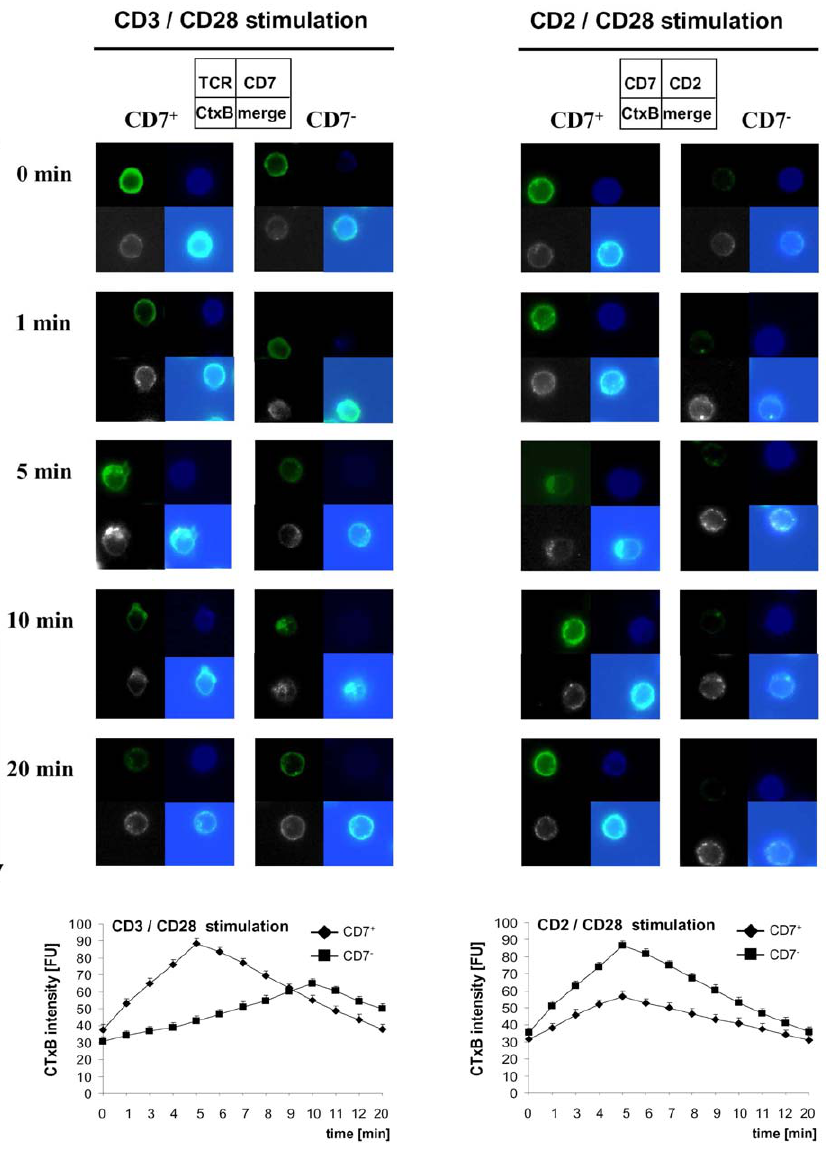
Figure 2. TCR synapse formation is impaired in late-stage T cells. CD8 + CD45RO + T lymphocytes were incubated on coverslips coated with the agonistic anti-CD3 mAb (UCHT-1) plus anti-CD28 mAb (CD28.2) or with the anti-CD2 mAbs (L303.1) and (L304.1) plus the anti-CD28 mAb (CD28.2). Cells were activated for various time intervals (1 min until 20 min), incubation was stopped by addition of paraformaldehyde, and cells were stained with TCR-alpha/betamAb (green) plus CD7 mAb (blue) or alternatively with CD2 mAb (blue) plus CD7 mAb (green) together with cholera toxin B (CtxB) (white) for lipid raft staining. Cells were analyzed on a LSM 510 with 630 6 microscope magnification. A minimum of 100 cells for each data point was recorded. Representative images after 0 min, 1 min, 5 min, 10 min and 20 min stimulation out of five independent experiments are shown. Synapse formation intensity (CTxB intensity) was quantified as described in Materials and Methods. A minimum of 100 cells of each cell population on each coverslip was recorded. Data represent mean scores from five experiments 6 standard error of the mean and were compared using a paired t-test. * p , 0.05. FU: fluorescence unit.